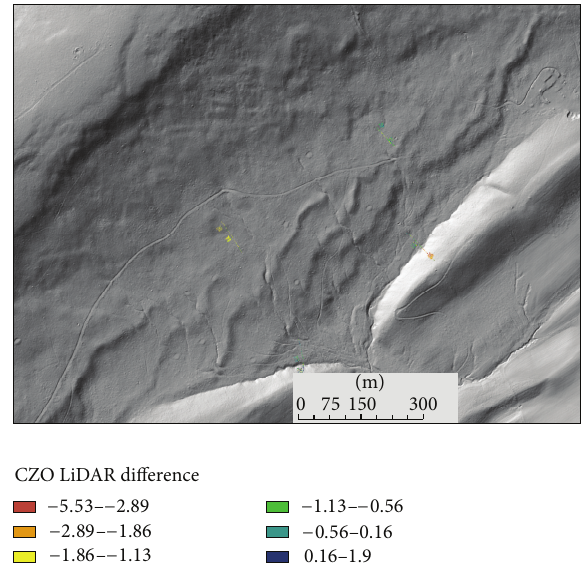
Figure 5: Differences between the surveyed elevations and PAMAP and CZO LiDAR. All values in the key are in feet to match the original units of the DEM.